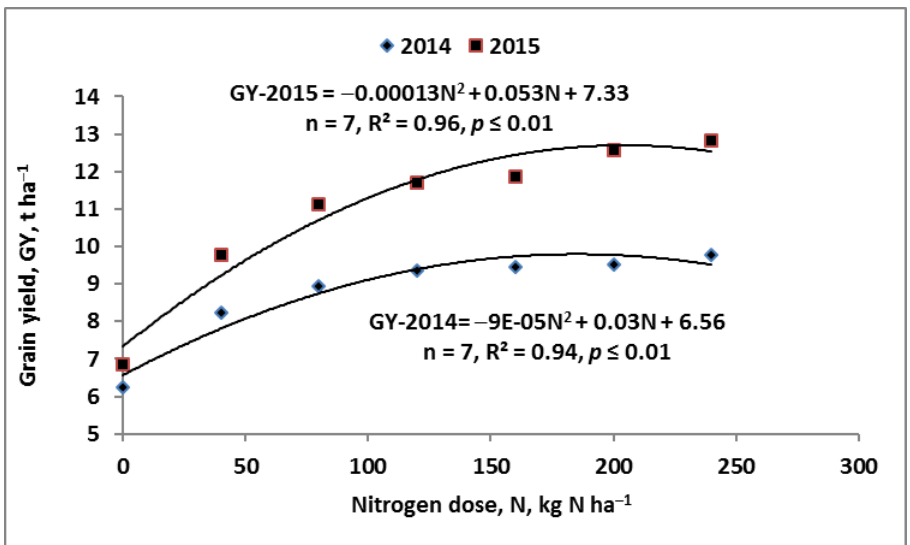
Figure A1. Response of winter wheat grain yield to the increasing rates of nitrogen fertiliser (consecutive).